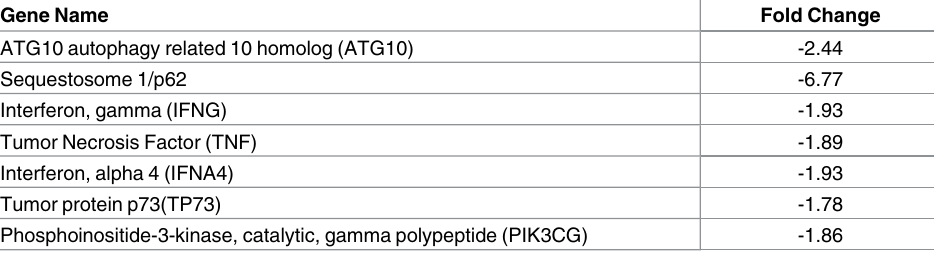
Table 1. Differentially expressedgenes after p62